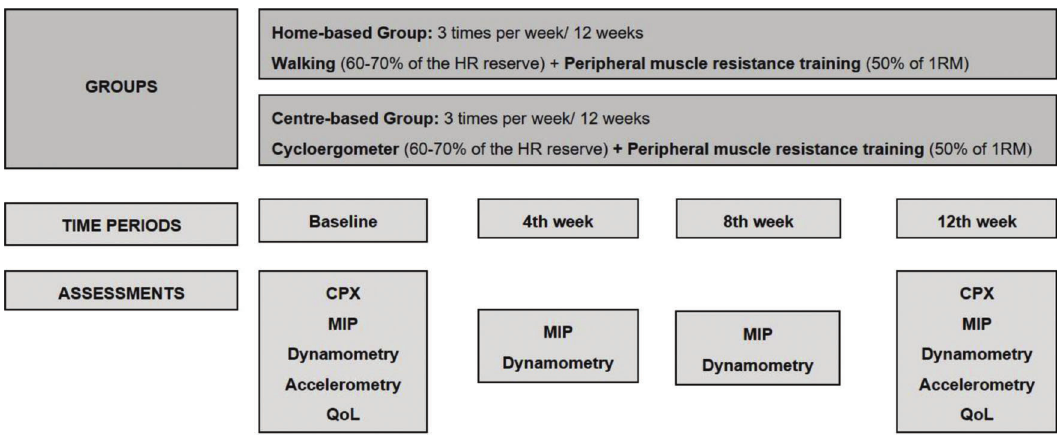
Figure 1 - Study design of interventions and assessments. CPX, cardiopulmonary test; HR, heart rate; 1RM, one repetition maximum; MIP, maximal inspiratory pressure; QoL, quality of life.